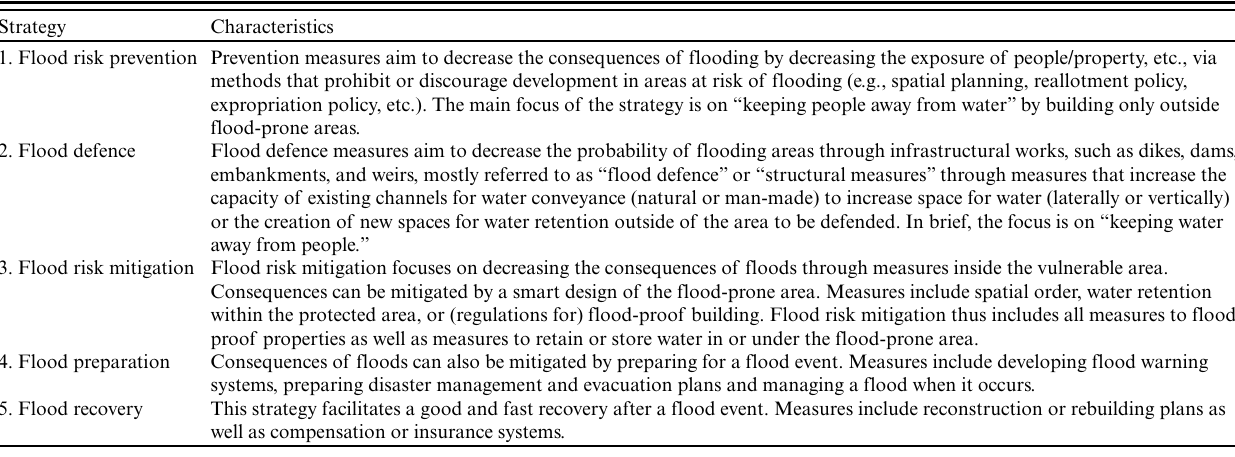
Table 1. Five types of flood risk management strategies (adopted from Hegger et al. 2014). Strategy